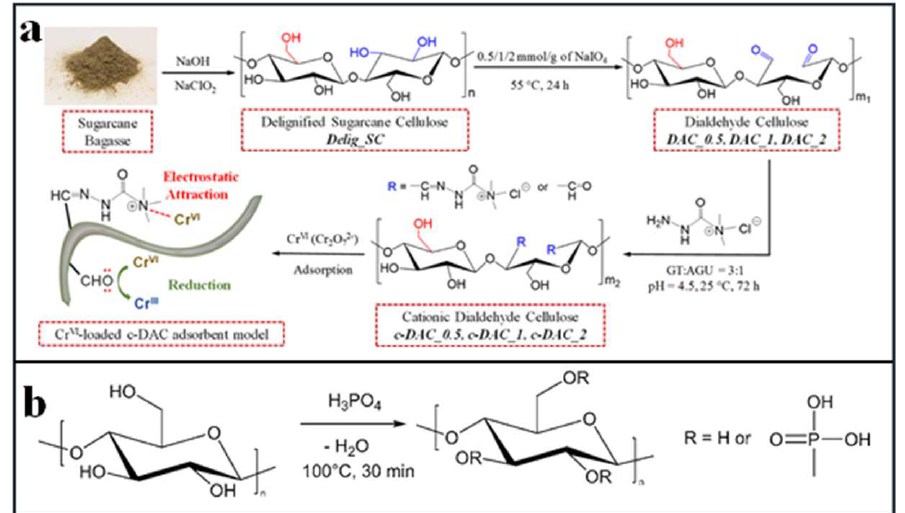
Figure 7. ( a ) Schematic illustration of the preparation of c-DAC adsorbent/coagulant and the corresponding adsorption mechanism for the removal of Cr(VI) from water. ( b ) Modification of cellulose nanofibrils with phosphate groups. Adapted with permission from [63]. Copyright 2020 American Chemical Society. Adapted with permission from [67]. Copyright 2016 Springer link.